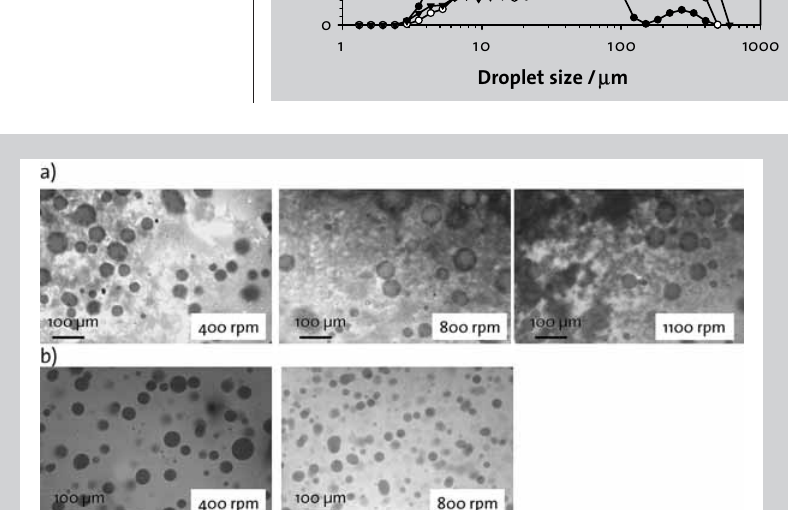
Figure 8 (above): Confocal microscopic pic- tures of maltodextrin/aga- rose composites at different phase volumes. The mal- todextrin rich phase (SA2 RP) appears light and agarose rich phase (Ag RP) dark. The rich phases were obtained from the phase separation of 12.5 % SA2 / 5 % Ag and mixed at 400 rpm. Figure 9 (middle): Size distribution of agarose rich phase droplets (Ag RP) from maltodextrin/agarose composites with different phase volumes. The rich phases were obtained from the phase separation of 12.5 % SA2 / 5 % Ag. Figure 10 (below): Confocal microscopic pic- tures of maltodextrin/aga- rose composites obtained by mixing 80% maltodextrin rich phase to 20 % agarose rich phase at different speeds (400, 800, 1100 rpm). a) cylindrical gels obtained from moulds and b) hot solutions directly quenched on a cover slide already set at